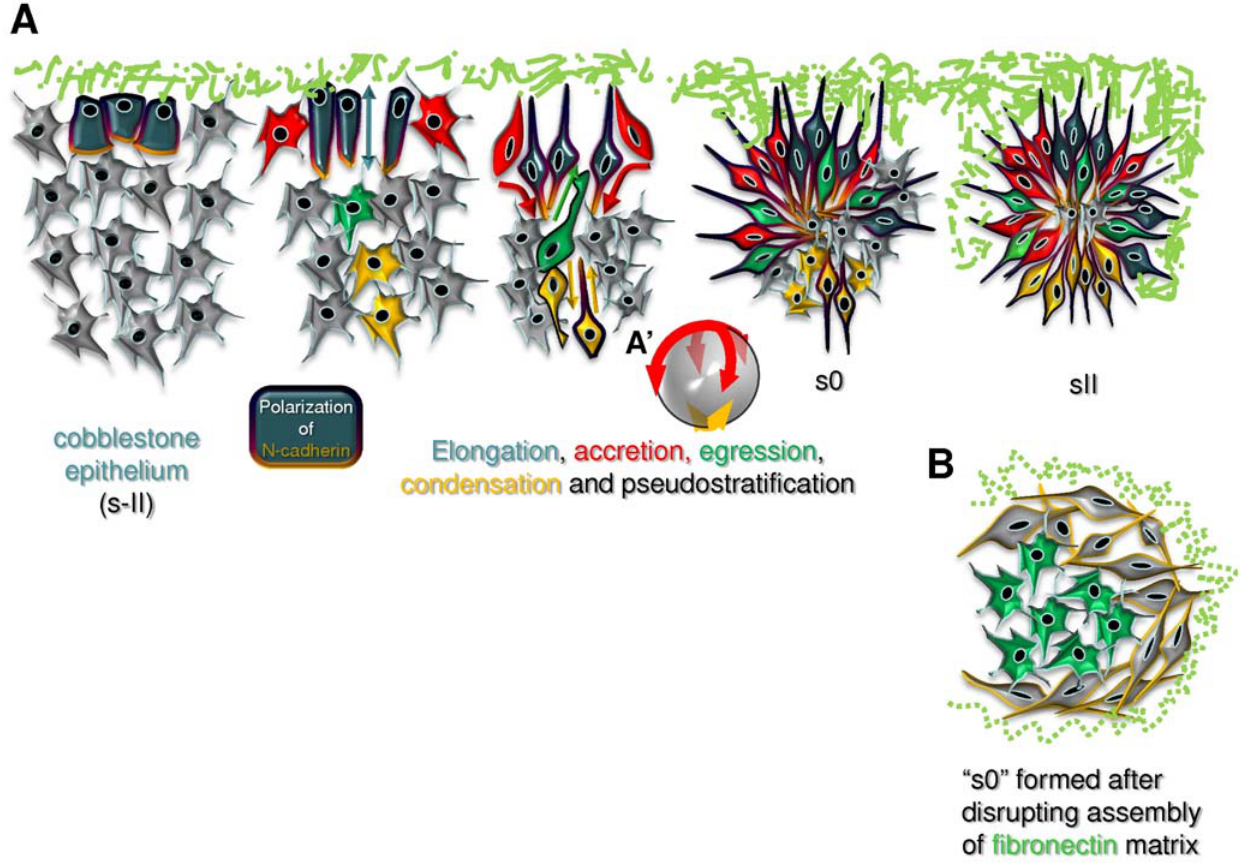
Figure 6. Model of morphological somite formation and morphogenetic movements. A ) Schematic representation of a ‘‘hypothetical’’ coronal slice representing stages of somite formation. Medial is up and rostral to the right. The different morphogenetic movements that contribute to the assembly of the somite epithelium are represented: Medial cells first become cuboidal with basal nuclei (dark green cells), then these cells elongate and recruit other cells to the epitheloid layer via accretion (red cells); accretion spreads ventrally and dorsally (not shown), and eventually to the caudal and rostral side. Simultaneously, cells egress from the core into the epitheloid layer (green cells), and, finally, at the lateral side of the somite, cells elongate, intercalate and condense (yellow cells). In s0, the rostral and lateral sides epithelialization is only completed after the somite separates from the PSM. The FN matrix is depicted in green. A 9 depicts how the accretion and condensation ‘‘spread’’ through the whole somite to complete the ‘‘spherical’’ ball of epitheloid cells. B ) When the assembly of the FN matrix is disrupted, PSM cells (especially caudal cells) do not polarize or orient centripetally and core cells fail to egress into the epithelium.